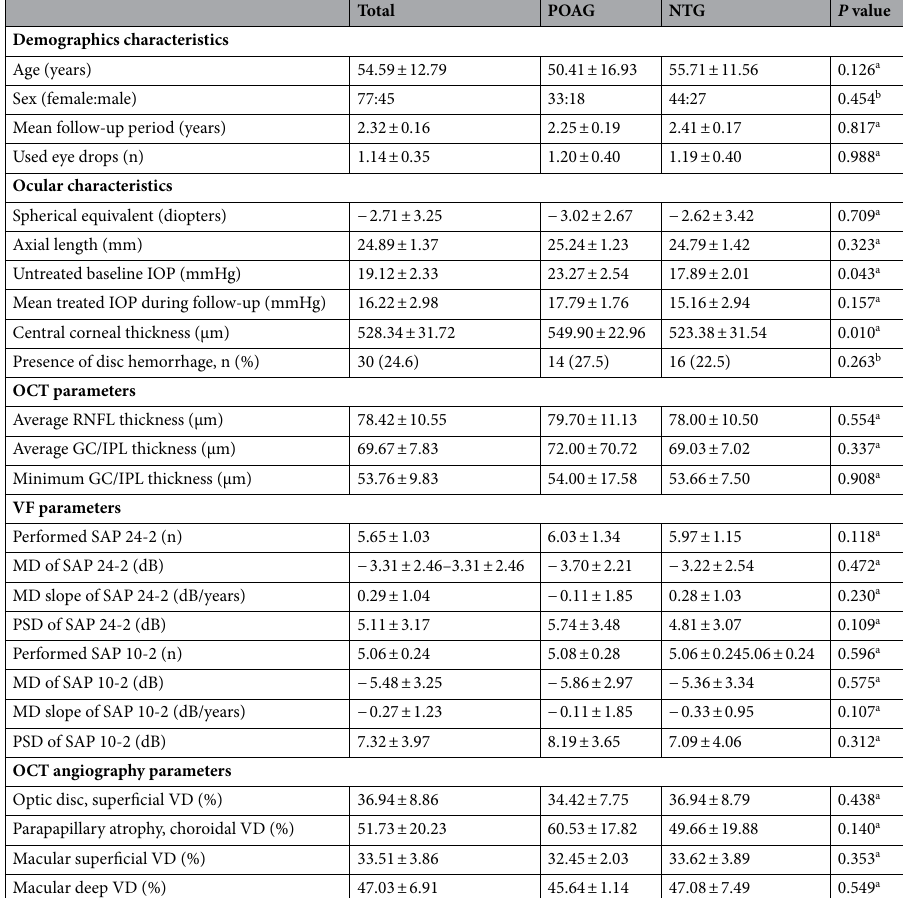
Table 1. Baseline characteristics of glaucoma patients who underwent serial 24-2 and 10-2 visual field tests. IOP, intraocular pressure; RNFL, retinal nerve fiber layer; mGC/IPL, macular ganglion cell/inner plexiform layer; SAP, standard automated perimetry; MD, mean deviation; PSD, pattern standard deviation; dB, decibels; POAG, primary open-angle glaucoma; NTG, normal-tension glaucoma. a Student t -test. b Chi-square